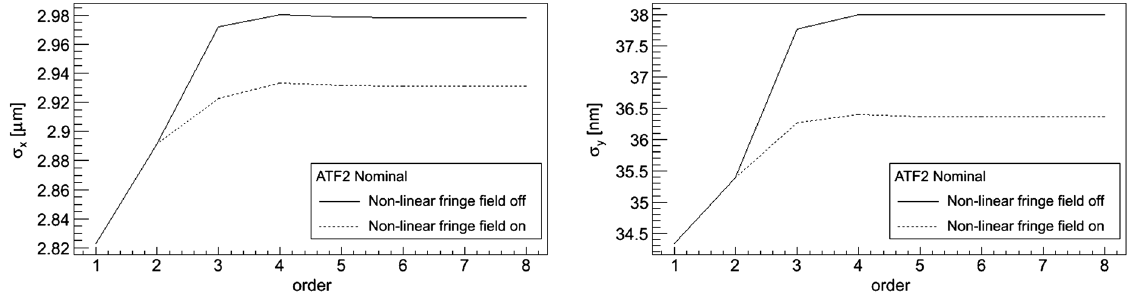
FIG. 11. Nonlinear fringe field impact on the horizontal (left) and vertical (right) beam size in the ATF2 nominal lattice.